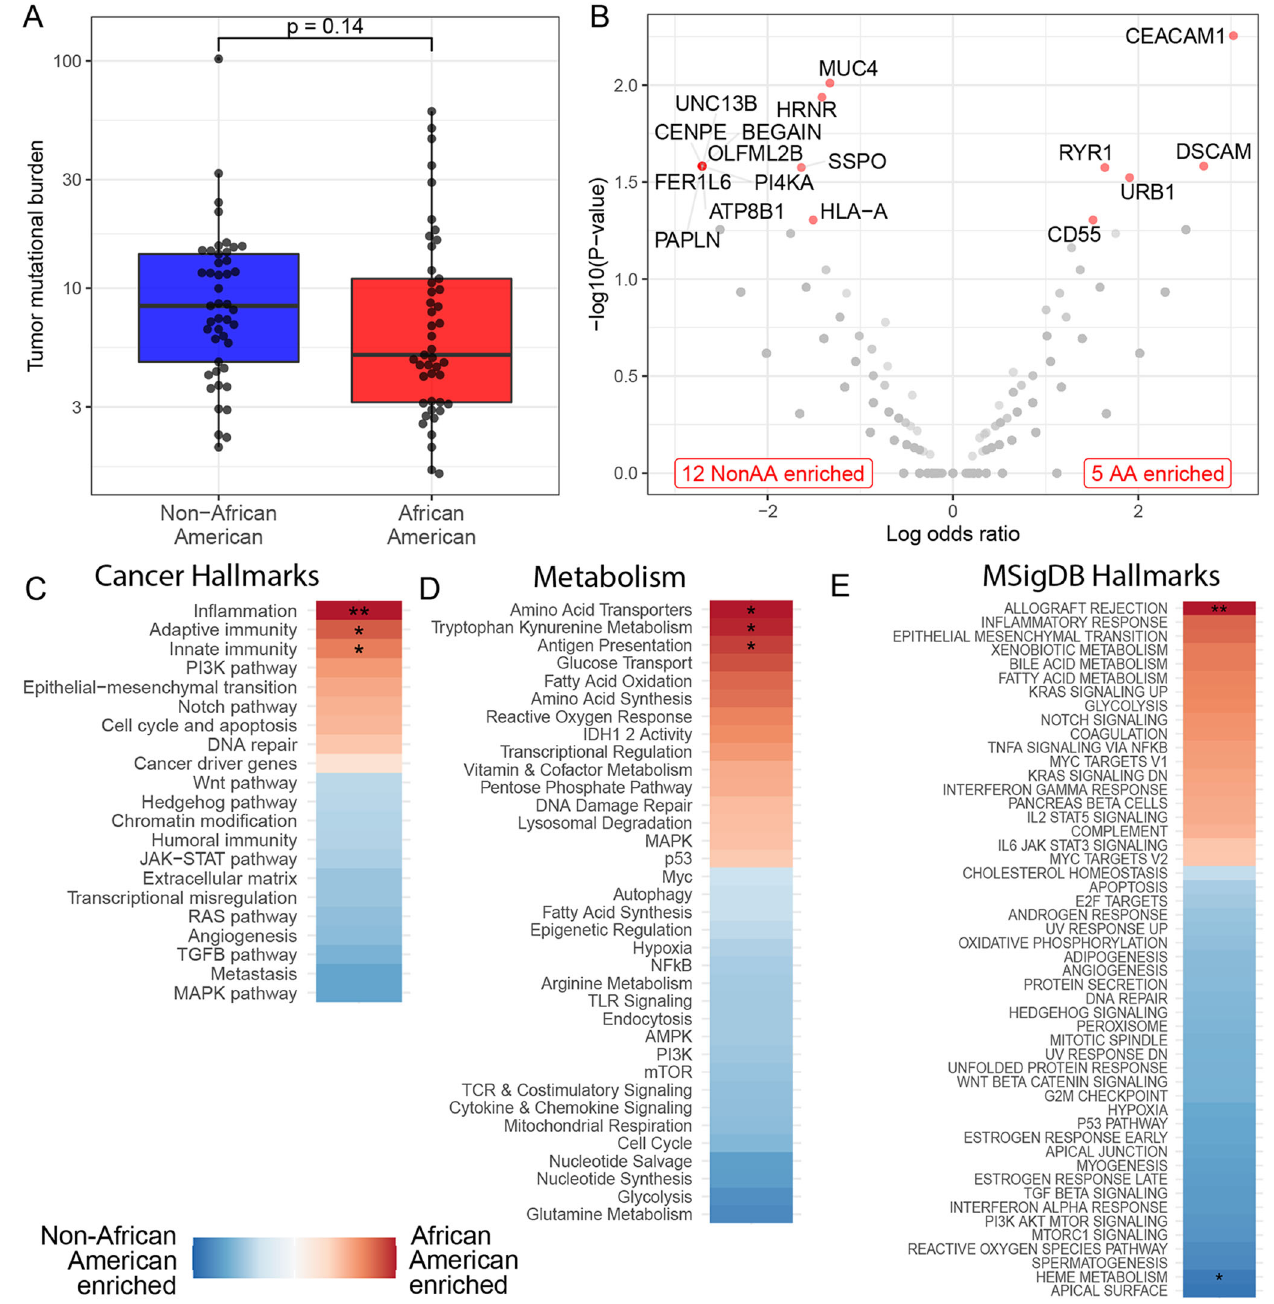
Fig. 1 Genes and pathways affected by somatic mutations in Non-African American (NonAA) and African American (AA) TNBC patients. A Tumor mutation burden with median (center line) and standard deviation. B Volcano plot of differentially mutated genes. Genes with signi fi cantly different mutation frequencies are labeled and marked red. C – E Differential enrichment of mutations in pathways. Color coding shows the directionality of enrichment. Stars indicate signi fi cantly differentially affected pathways (* p < 0.05, ** p < 0.01, *** p < 0.001; Mann – Whitney Test, Wald Test, Permutation